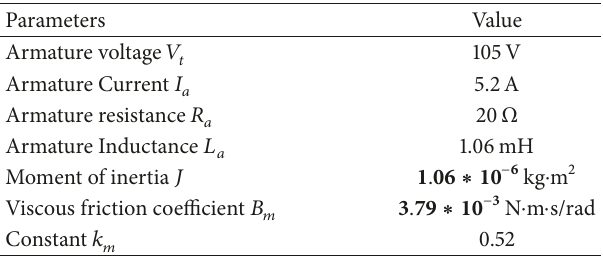
Table 5: PMDC motor parameters.